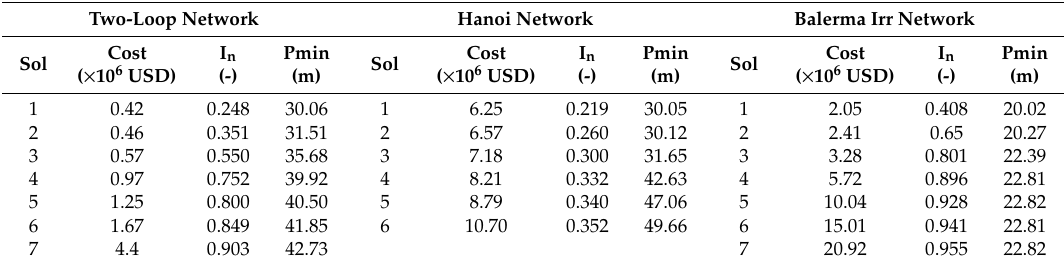
Table 8. Characteristics of optimal network